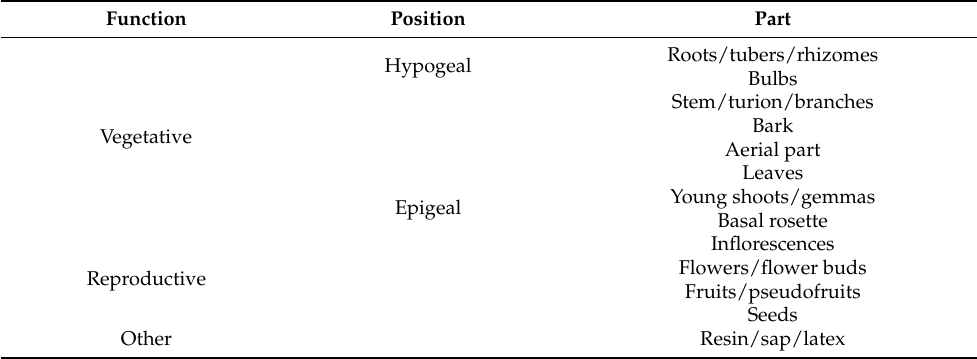
Table 3. Function, position, and parts of the plants used